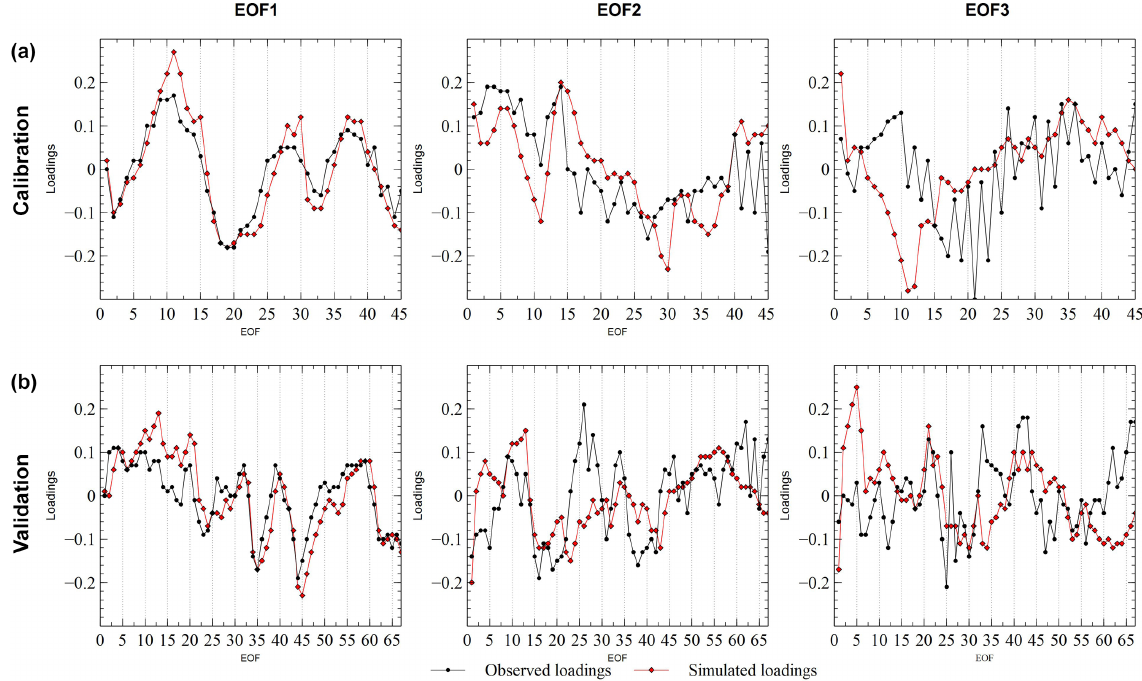
Figure 3. The three first EOFs during the calibration (a) and during the validation (b) are represented. The y axes reflect the unitless loadings of each EOF. The x axes reflect the time step.